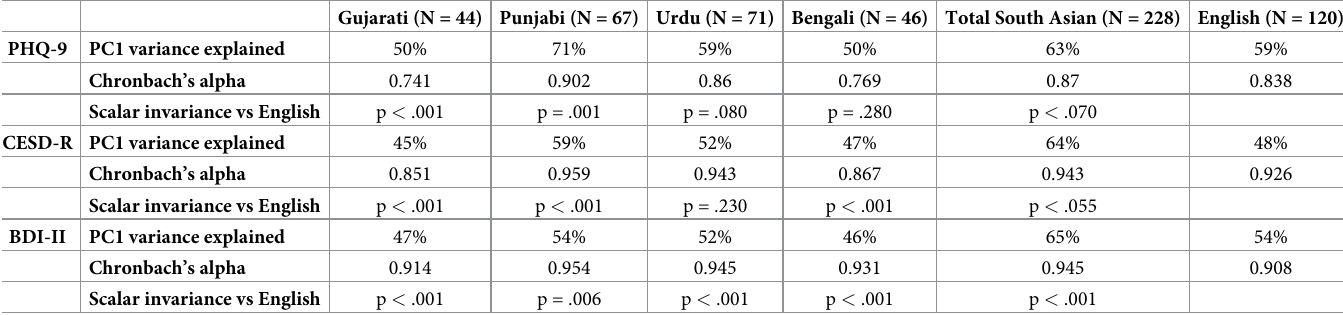
Table 4. Measurement equivalence of translated depression screening